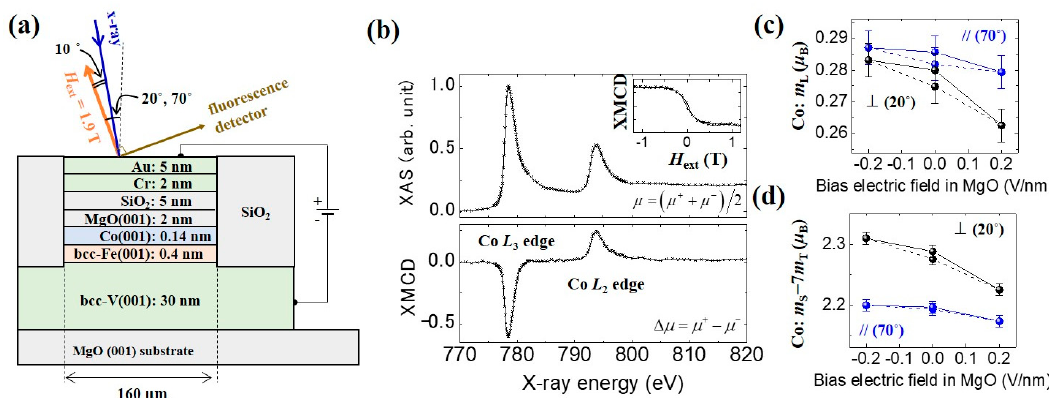
Figure 8. Voltage-induced changes to the magnetic moment of Co in the Fe/Co/MgO system. ( a ) Schematic of the sample structure. ( b ) Typical XAS/XMCD results around the Co-absorption edges. ( c ) Voltage-induced change to the orbital magnetic moment in Co. ( d ) Voltage-induced changes to the effective spin magnetic moment ( m S − 7 m T ) in Co. Reprinted figure with permission from [113], Copyright 2017 by the American Physical Society.